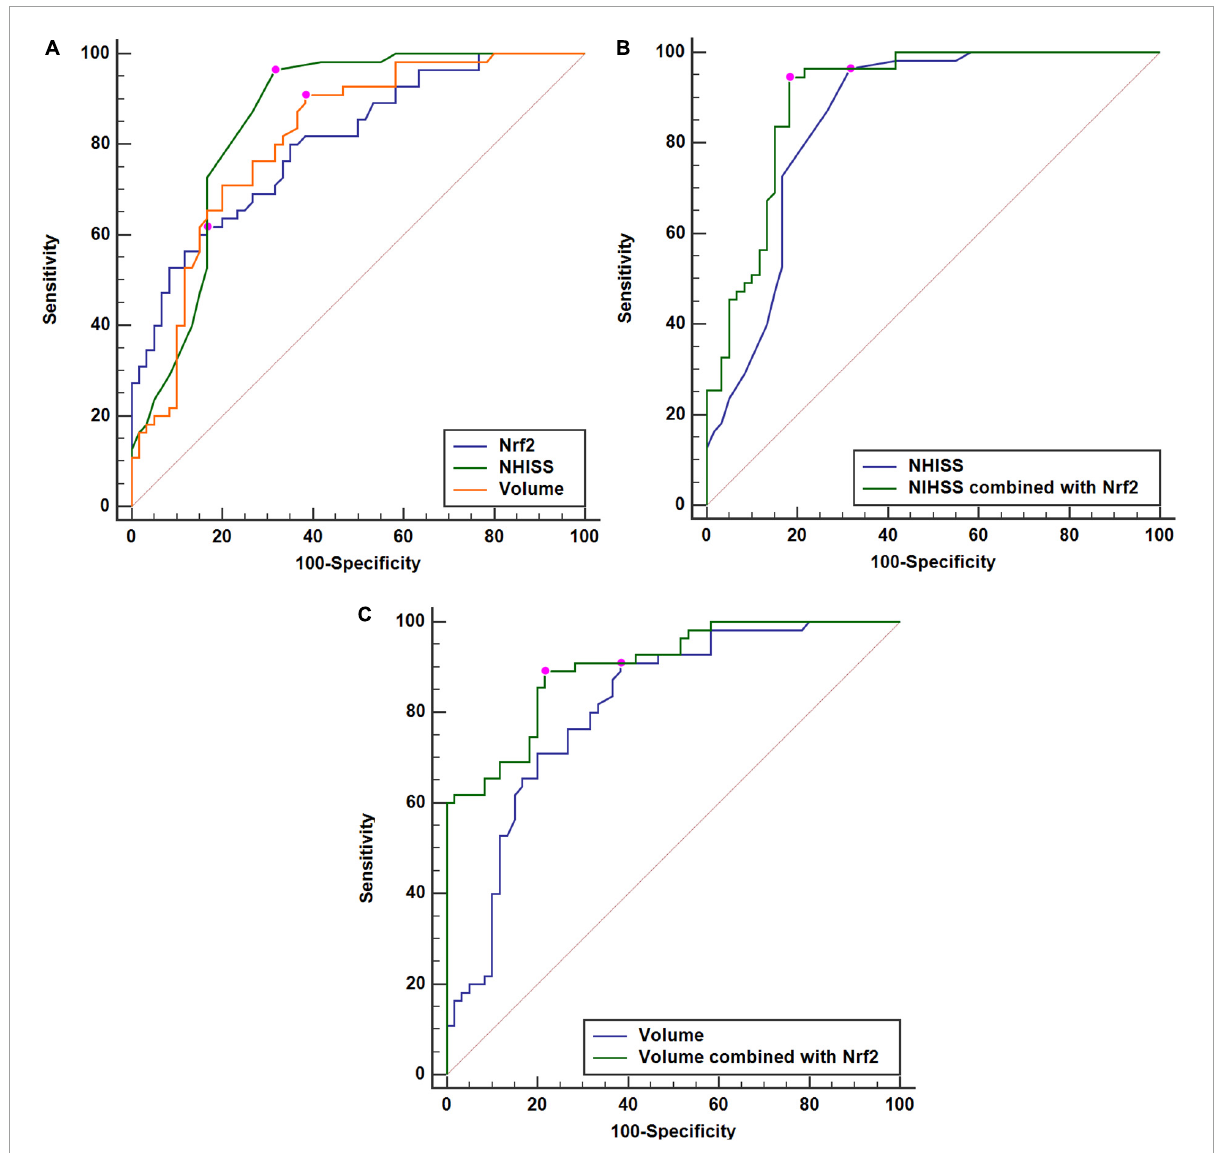
FIGURE7 Comparisons of discriminatory capabilities for post-stroke 90-day poor prognosis among serum nuclear factor erythroid 2-related factor 2 (Nrf2) levels, National Institutes of Health Stroke Scale (NIHSS) scores, and hematoma volume after acute supratentorial intracerebral hemorrhage (ICH). (A) Comparisons of areas under curve for post-stroke 90-day poor prognosis among serum Nrf2 levels, NIHSS scores, and hematoma volume after acute supratentorial intracerebral hemorrhage (ICH). (B) Comparison of areas under curve for post-stroke 90-day poor prognosis between serum Nrf2 levels combined with NIHSS scores and NIHSS scores after acute supratentorial ICH. (C) Comparison of areas under curve for post-stroke 90-day poor prognosis between serum Nrf2 levels combined with hematoma volume and hematoma volume after acute supratentorial ICH. Serum Nrf2 levels had similar area under curve, as compared to NIHSS scores and hematoma volume (both P > 0.05). Moreover, serum Nrf2 levels profoundly improved areas under curve of NIHSS scores and hematoma volume (both P < 0.05). Poor